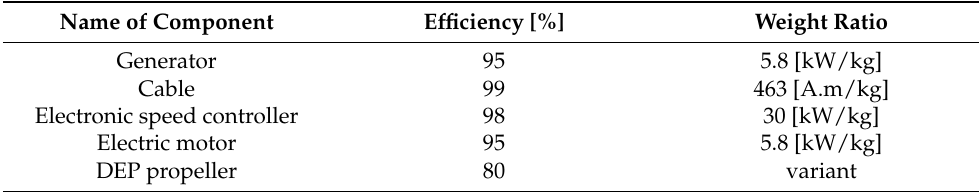
Table 1. List of DEP components with efficiency and power to weight